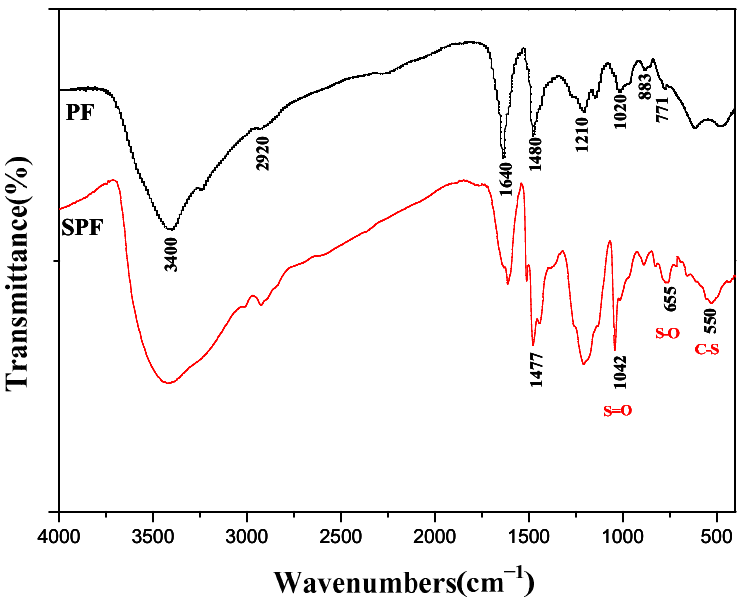
Figure 3. FTIR spectra of SPF and PF resin samples (PF resin: F/P was 2.0, and S/P was 0; SPF resin: F/P was 2.0, and S/P was 0.2).